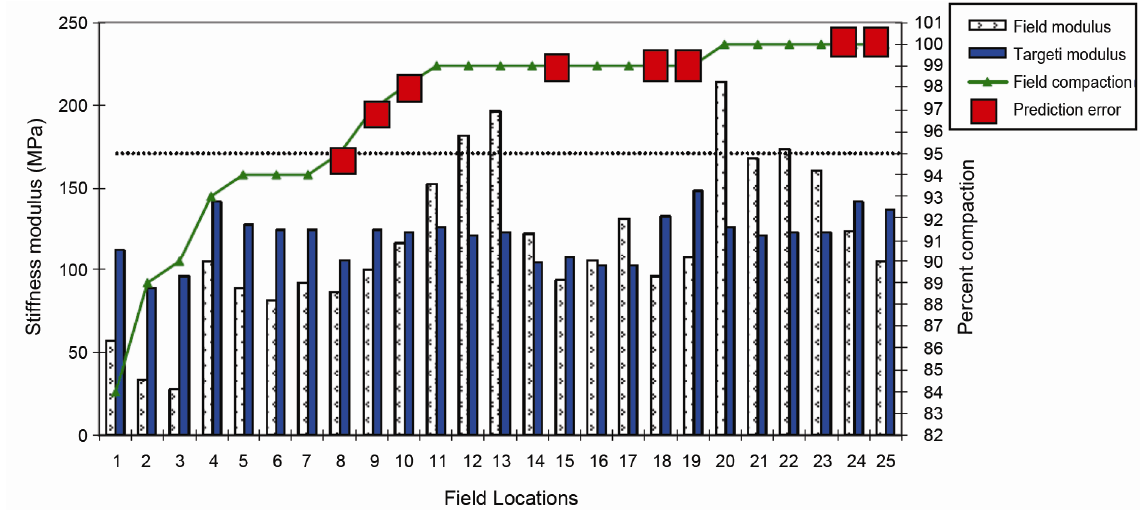
Fig. 11. Applicability of laboratory model in filed locations